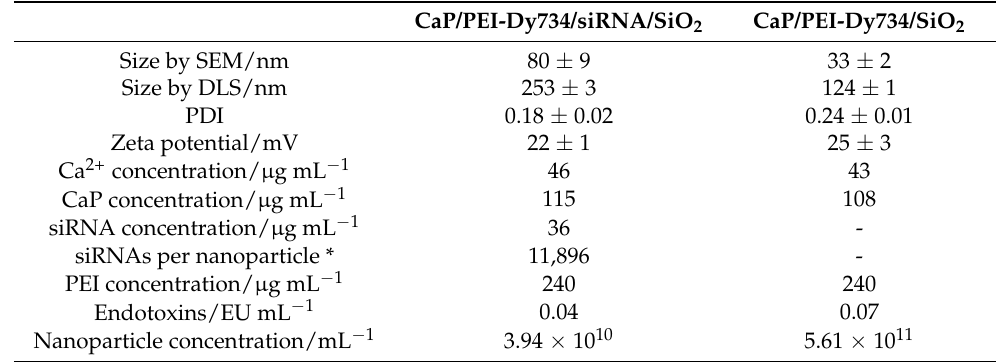
Figure 3. Physicochemical features of fluorophores and nanoparticles. ( I ) NIR fluorescence emission spectra of the free Dy734 dye (left), PEI–Dy734 complex (center), and representative reference Dy734-labeled calcium phosphate nanoparticles (CaP/PEI-Dy734/SiO 2 ) (right) with marked emission maxima. The samples were excited at λ = 720 nm. The nanoparticle sample was diluted with water (1:4 v / v ) for the measurement. ( II ) Normalized particle size distributions (A1). ( III ) normalized particle zeta potentials (A2). ( IV ) SEM micrographs of the representative nanoparticles (A3). The nanoparticle formulations are presented as follows: CaP/PEI–Dy734/siRNA/SiO 2 (A) and CaP/PEI–Dy734/SiO 2 (B). For detailed nanoparticle characterization, see Table 2. Table 2. Characterization data of representative calcium phosphate nanoparticles from typical synthesis batches used in in vivo gene silencing experiments. CaP—calcium phosphate, DLS—dynamic light scattering, Dy—Dyomics, EU—endotoxin units, PDI—polydispersity index, PEI—polyethyleneimine, RNA—ribonucleic acid, SEM—scanning electron microscopy, siRNA—small interfering RNA. * Double-stranded siRNA molecules (duplexes).